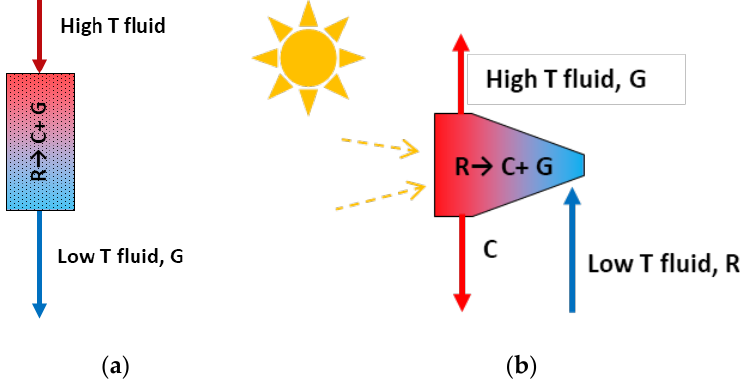
Figure 2. ( a ) Conceptual scheme of adiabatic reactor (fixed or fluidized bed); ( b ) Conceptual scheme of directly irradiated reactor. directly irradiated